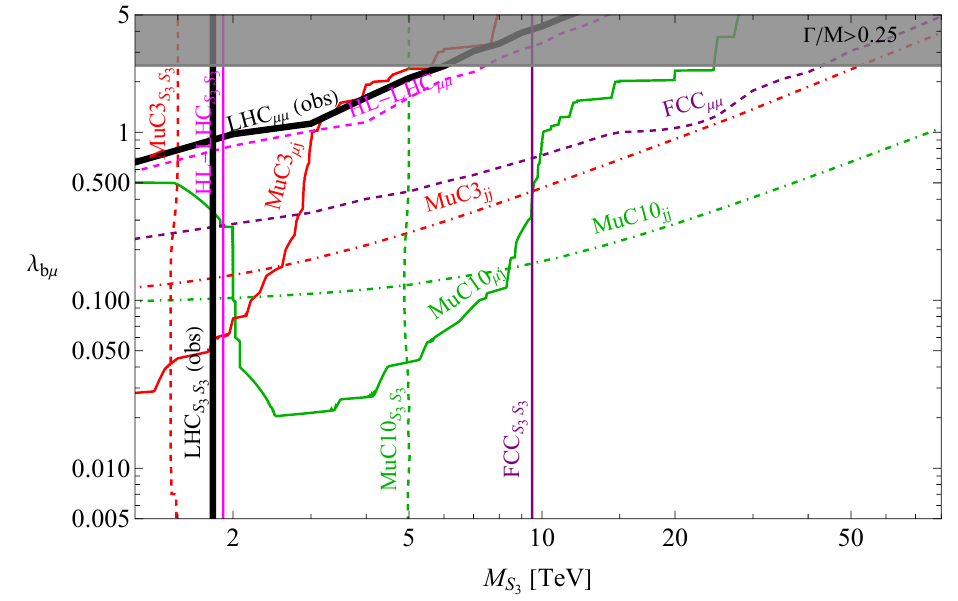
Figure 13 . The 5 σ discovery prospects at future colliders for the S 3 leptoquark assuming the U(2) 3 quark flavour symmetry and the exclusive leptoquark coupling to muons (see section 6.1). The present LHC exclusions at 95% CL are shown as a thick black line. The perturbativity limit Γ S /M S < 0 . 25 is violated in the grey region. The labels for various colliders and processes are on 3 3 the discoverable side of a